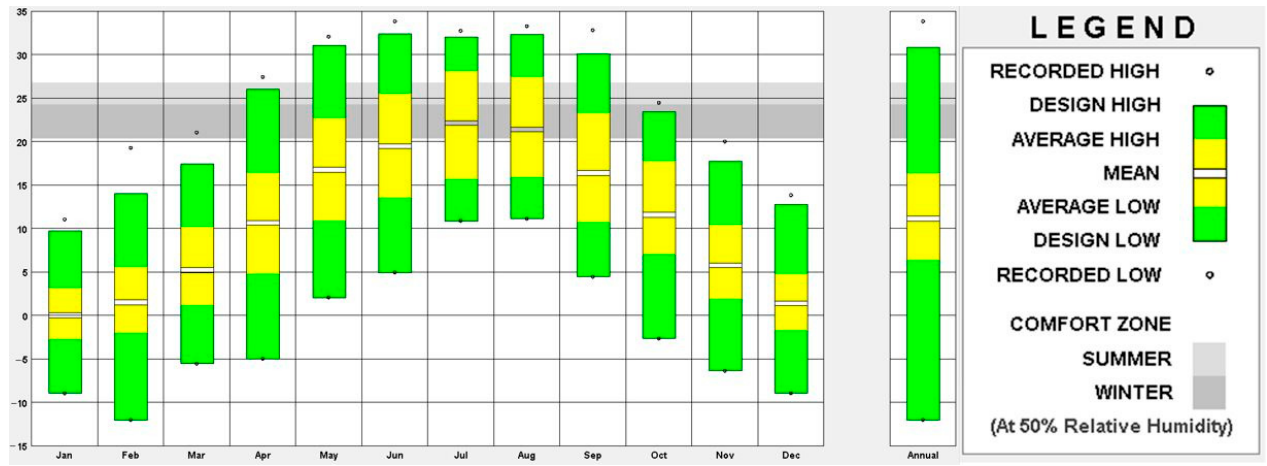
Figure 3. Temperature range for Timi ș oara (IWEC Data, 152,470 WMO Station). Reprinted from [21,22]. The annual average relative humidity is 80% in Timi ș oara, where June is the month with the highest rainfall (76 mm average rainfall) and February is the driest month (36 mm average rainfall) [20].